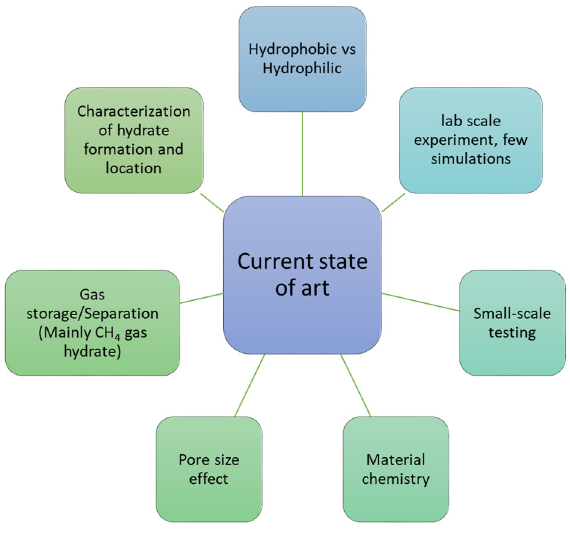
Figure 17. Current state of art based on available research on MOF–hydrate synergy.